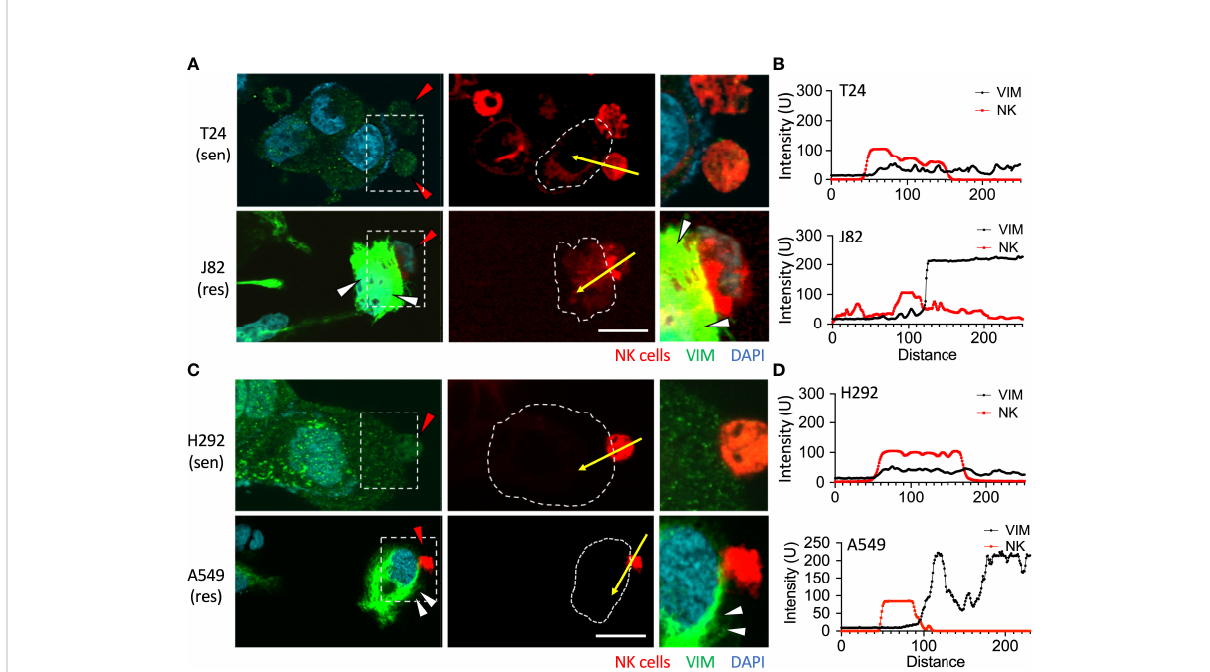
FIGURE 4 Upregulation of vimentin upon NK cell interaction. (A) T24 or J82 cells were co-cultured with NK cells for 6 h and stained with a vimentin antibody. The stained cells were observed using a fl uorescence microscope. (C) H292 and A549 cells were co-cultured with NK cells for 6 h and stained with a vimentin antibody. The stained cells were observed using a fl uorescence microscope. (B, D) The intensity of upregulated vimentin in the cancer cells was measured and quanti fi ed by ImageJ. Red arrowhead, NK cell; white arrowhead, vimentin upregulation. Scale bars, 20 m m. Experiments were repeated at three times (n =